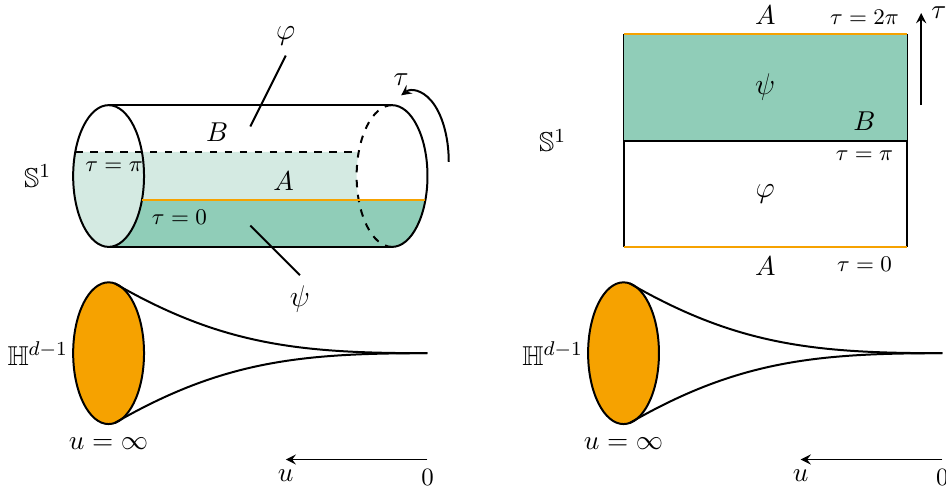
Figure 11 . The Euclidean configuration for the pseudo entropy across the spherical entangling surface after the CHM map [Left] and the path integral representation of the transition matrix τ ψ | ϕ